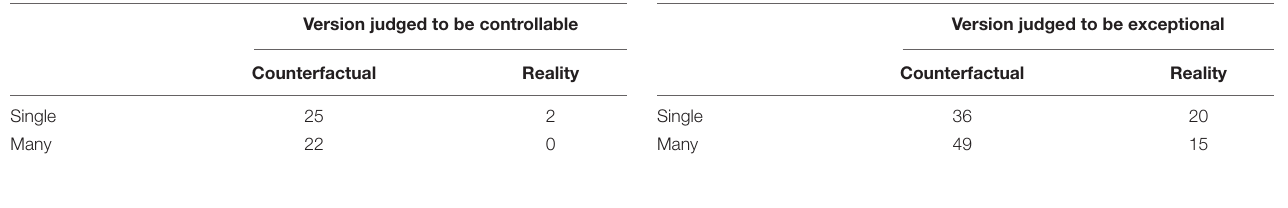
TABLE 3 | Number of participants inferring that the event was